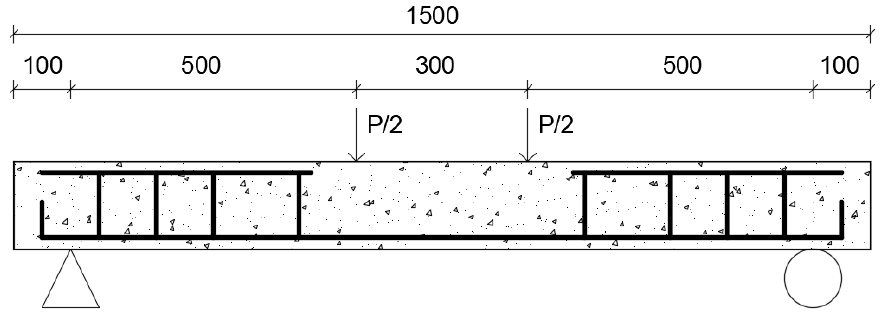
Figure 4. Diagram of loading (unit: mm).